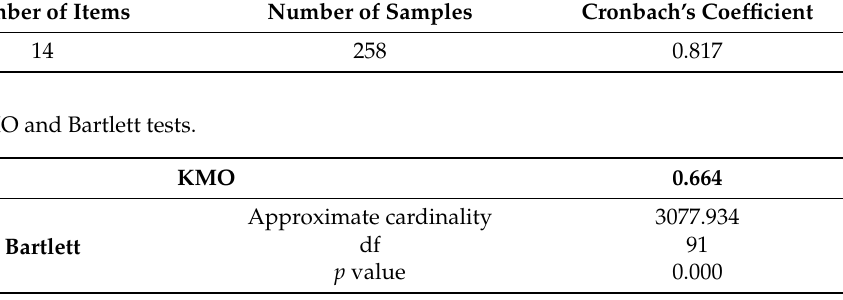
Table 3. Cronbach reliability analysis.